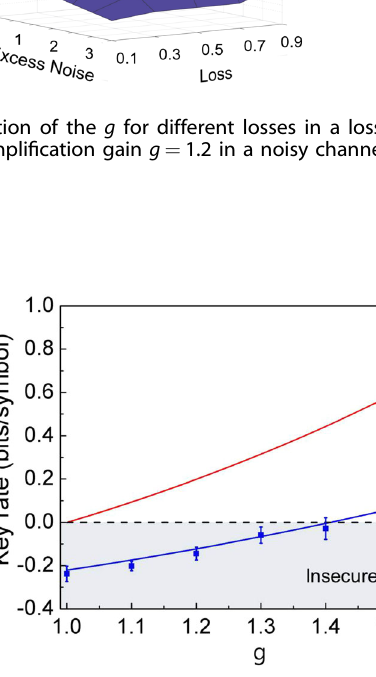
Fig. 6 The secret-key rate for 1sDI QKD with continuous variables in the case of reverse reconciliation. The red curve represents the theoretical key rate given by a pure TMSS with − 6 dB squeezing. The blue curve represents the key rate given by the initial state with − 4.2 dB squeezing and 7.3 dB antisqueezing. The cutoff is selected as β c = 4.5. Error bars correspond to one standard deviation from statistical data. The region with negative key rate is the insecure